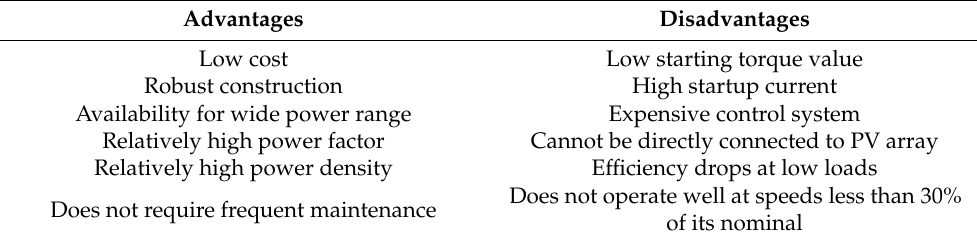
Table 2. Advantages and disadvantages of DC machines.